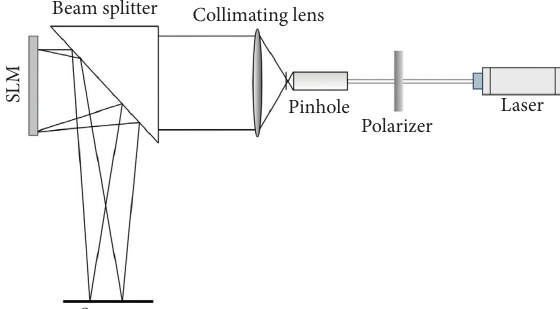
Figure 5: Hologram display system.